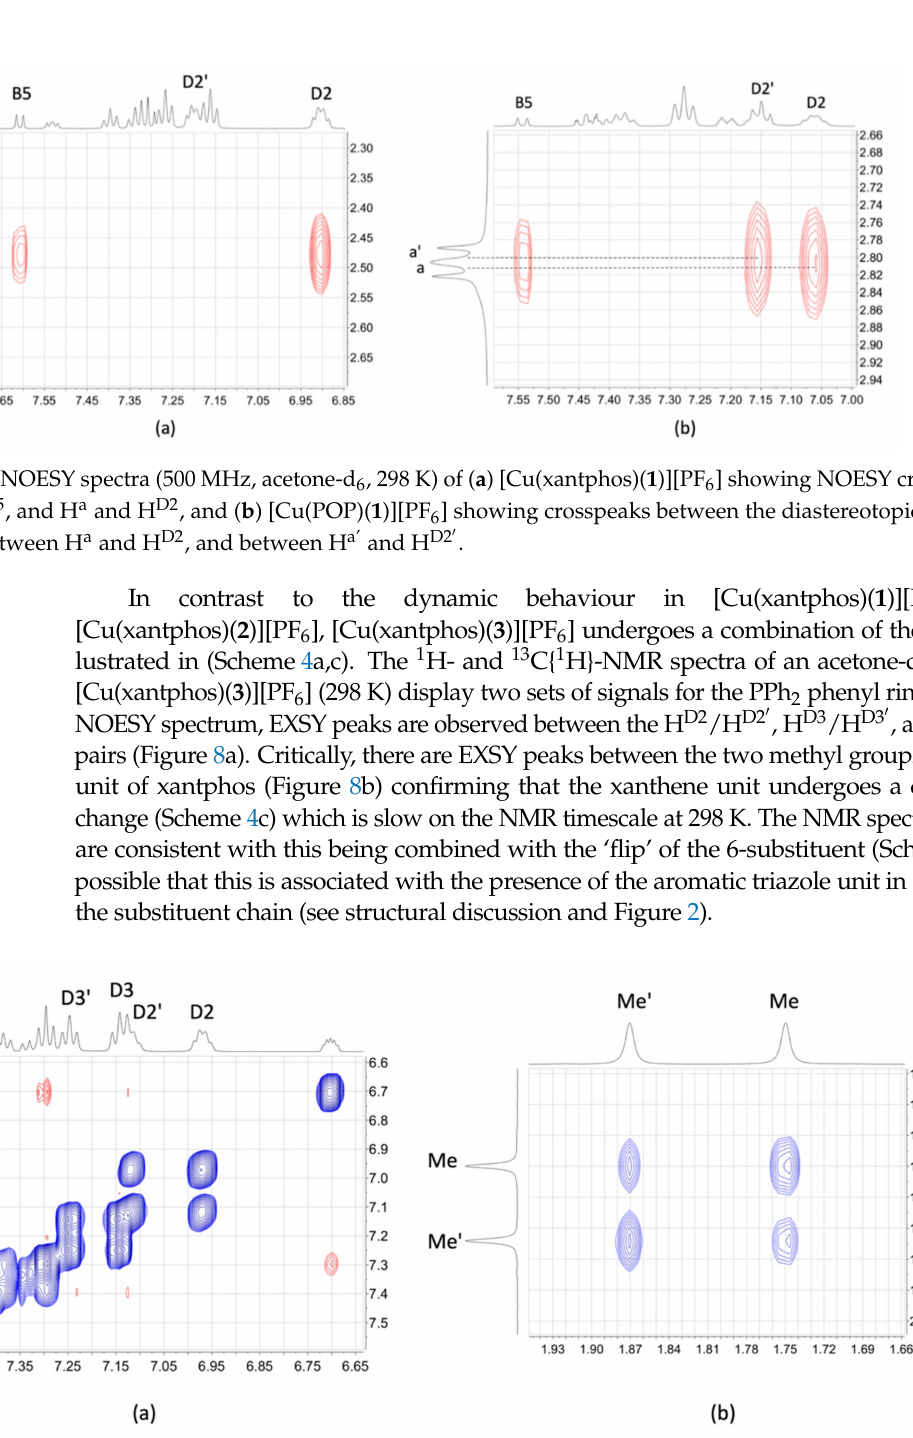
Figure 8. Part of the NOESY spectra (500 MHz, acetone-d 6 , 298 K) of [Cu(xantphos)( 3 )][PF 6 ]. ( a ) The EXSY between H D2 and H D2 (cid:48) , and between H D3 and H D3 (cid:48) ; the EXSY peaks between H D4 and H D4 (cid:48) are also visible close to the diagonal. ( b ) EXSY peaks between H Me and H Me’ in the xanthene